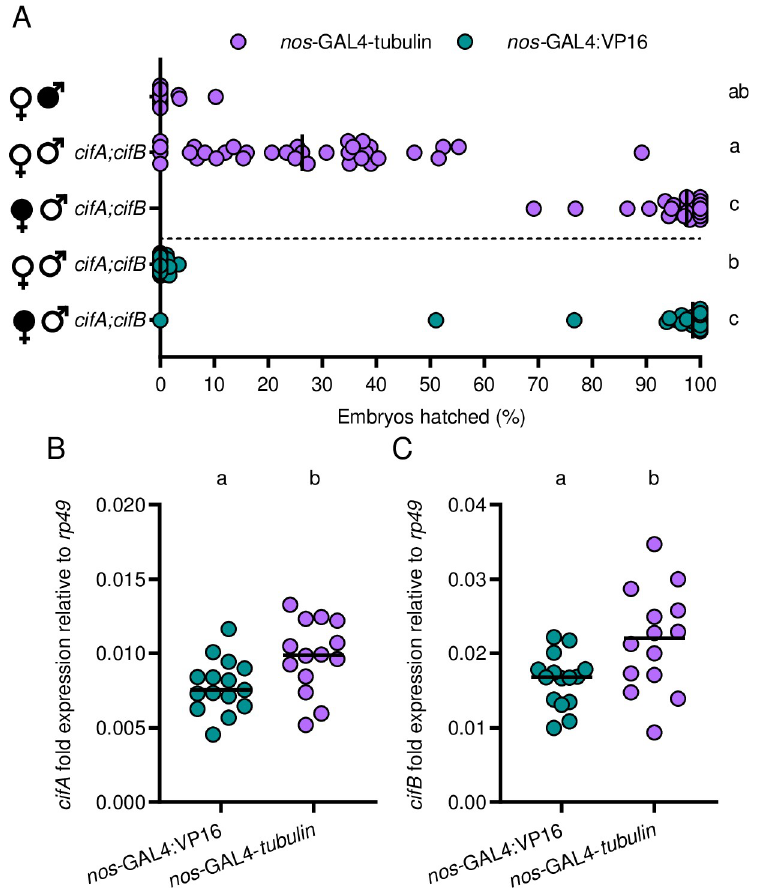
Fig 2. cifA wMel and cifB wMel induce strong CI when transgenically expressed in males under the nos -GAL4:VP16 driver. (A) Two different driver lines, nos -GAL4- tubulin (purple; top) and nos -GAL4:VP16 (green; bottom) were tested for their ability to induce CI when transgenically expressed in uninfected, male Drosophila . Filled sex symbols represent infection with w Mel Wolbachia , and gene names to the right of a symbol represent expression of those genes in the male line. Vertical bars represent medians. Letters to the right indicate significant differences with an α = 0.05 calculated by a Kruskal-Wallis analysis followed by Dunn’s multiple comparison test. (B,C) To test if nos -GAL4- tubulin and nos -GAL4:VP16 generate different levels of gene expression, (B) cifA wMel and (C) cifB wMel fold expression difference relative to the Drosophila housekeeping gene rp49 in male abdomens under the two drivers was measured using qPCR. Males tested for gene expression were the same used in the hatch rate experiment in A. Letters above indicate significant differences with an α = 0.05 calculated by a Mann-Whitney U test.